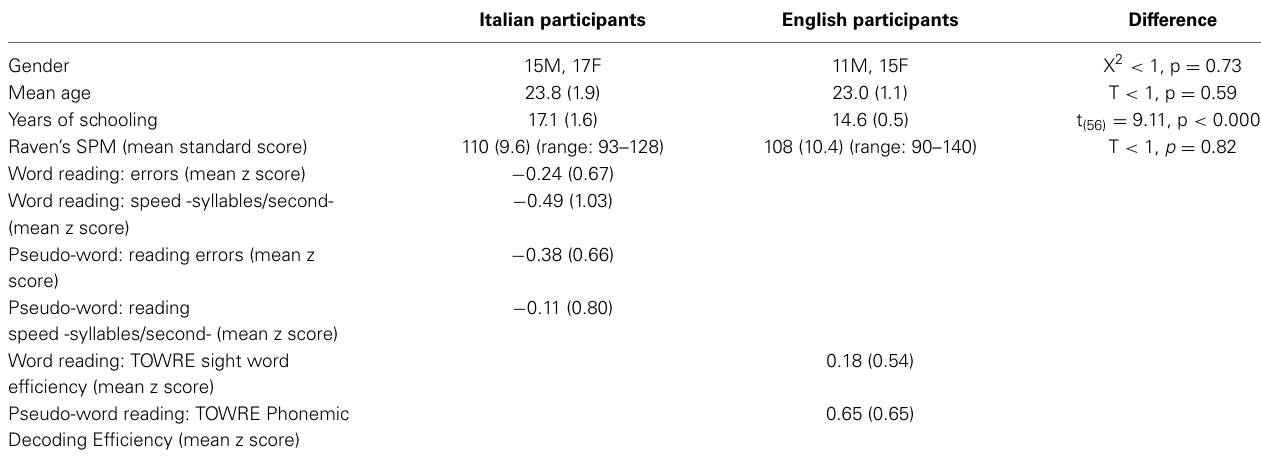
Table 1 | Socio-demographic information and reading and Raven’s SPM performance for the Italian and English samples of Experiments 2 and 3.